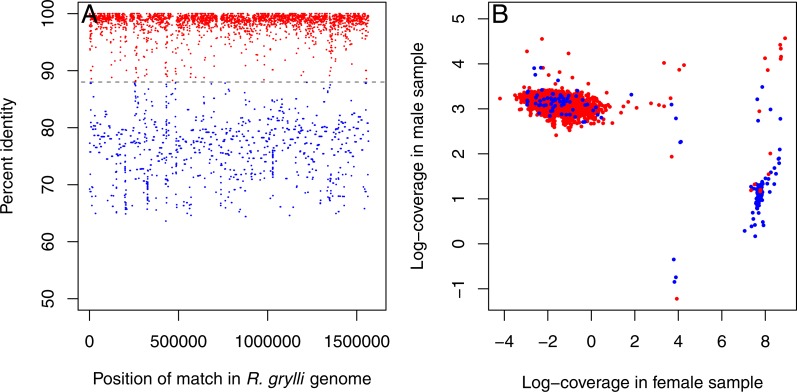
Rickettsiella contigs in initial assembly.Initial assembly of all Trachelipus rathkei sequencing data seems to contain contigs coming from two distinct Rickettsiella lineages. (A) One set of contigs displays high similarity to R. grylli
NZ_AAQJ00000000 (red dots), while the contigs in the other set are more divergent (blue dots), but contigs in both sets seem to span the entire length of the R. grylli genome. (B) The two sets of contigs also form two distinct clusters based on sequencing depth in the two T. rathkei samples; the high similarity contigs are present at moderate depth in the male sample and very low depth in the female sample, while the low similarity contigs are present at very high depth in the female sample and low depth in the male sample; only a small number of contigs seem to be mis-classified.